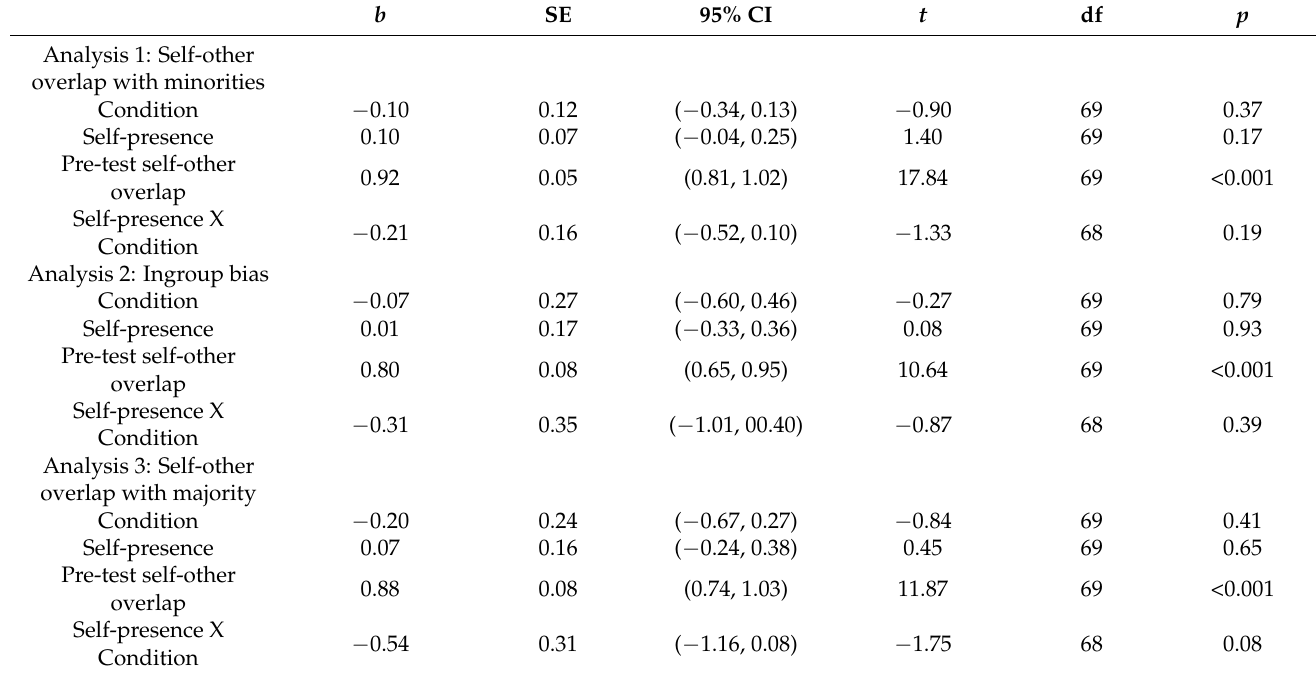
Table 2. Self-other Overlap Regression Analyses (Study 2; n =